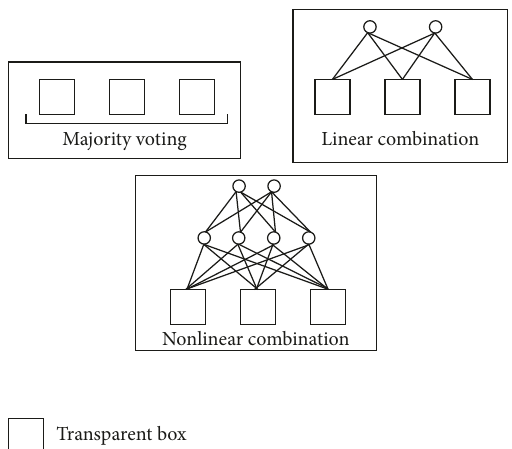
Figure 2: Ensembles of DIMLP aggregated by majority voting, linear combination, and nonlinear combination.